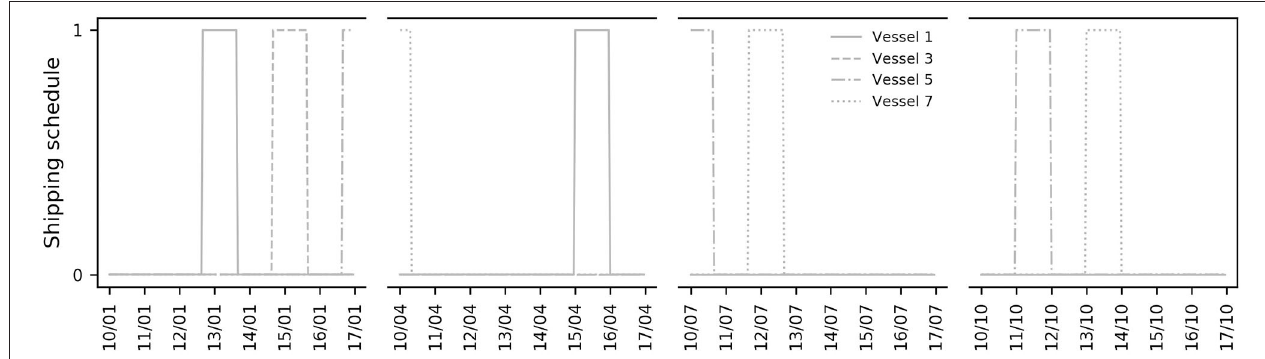
FIGURE 5 | Subset of non-overlapping schedules used to construct the aggregate schedule π n t of stylised liquefied methane carriers. These time series are summed to obtain the aggregate schedule π n t . For all other nodes except wind and solar PV power plants, π n t = 1 over the entire time horizon.